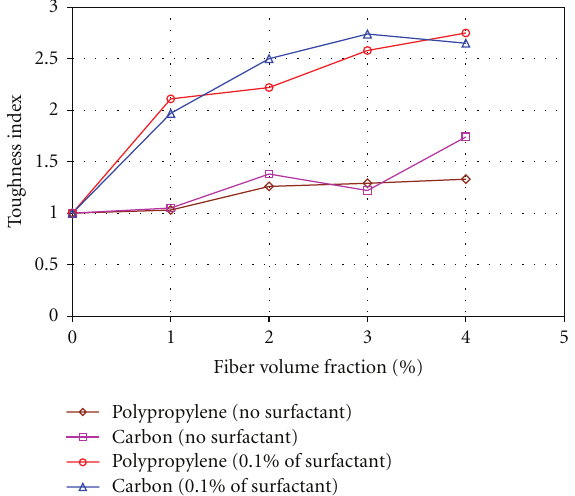
Figure 6: Toughness index versus fiber volume fraction.